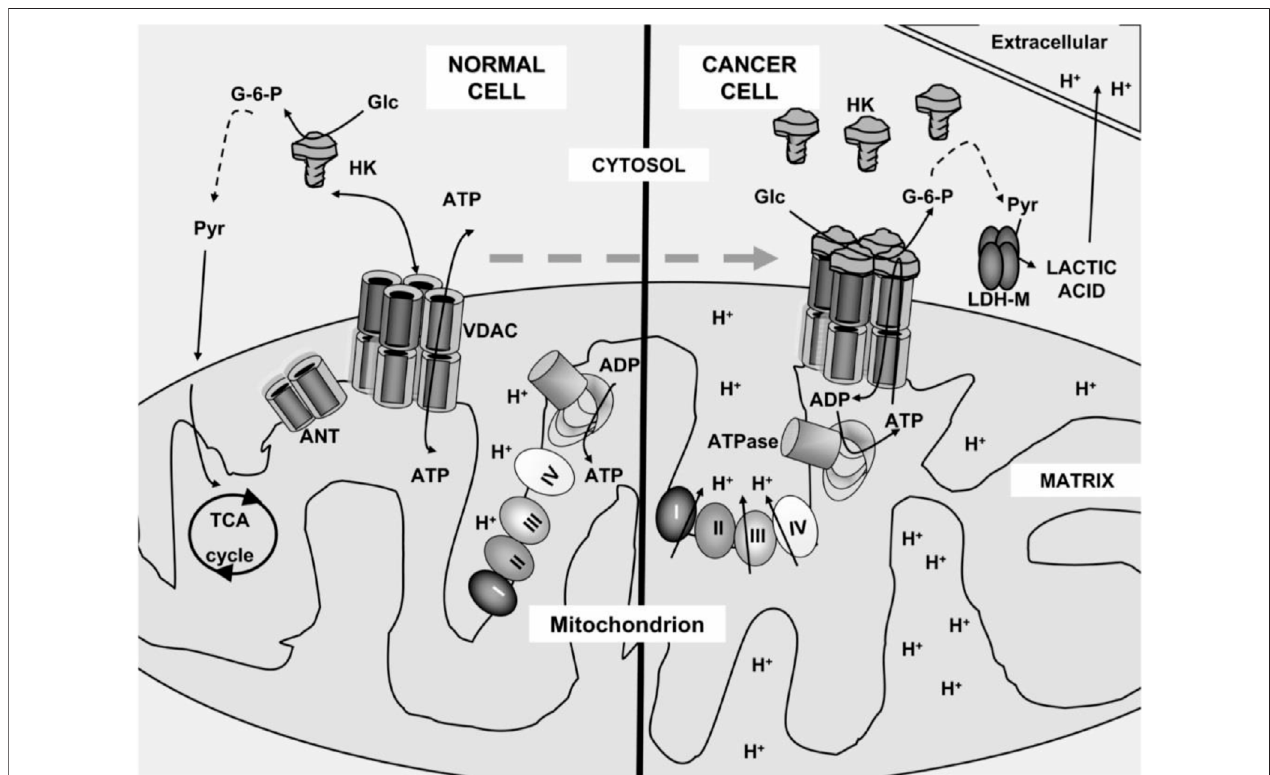
FIGURE 1 | Mitochondrial metabolism of a normal cell and a cancer cell. In the normal cell, pyruvate was carried into the mitochondria and converted into the tricarboxylic acid cycle. However, in the cancer cell, pyruvate did not enter into the mitochondria as it converted to lactic acid and acidi fi ed the extracellular milieu (Ralph and Neuzil,